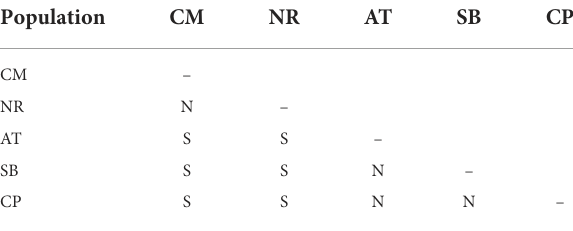
and indicated that all populations of T. rubidus were markedly overlapped. This map was defined by the first two DF axes, which accounted for 75.4% of the total shape variation for T. rubidus (DF1 = 43.2% and DF2 = 32.2%). The pairwise Mahalanobis distances were significantly different among the populations ( p < 0.05, Table